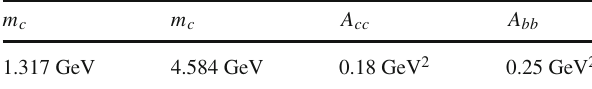
Table 1 Parameters for quarkonium